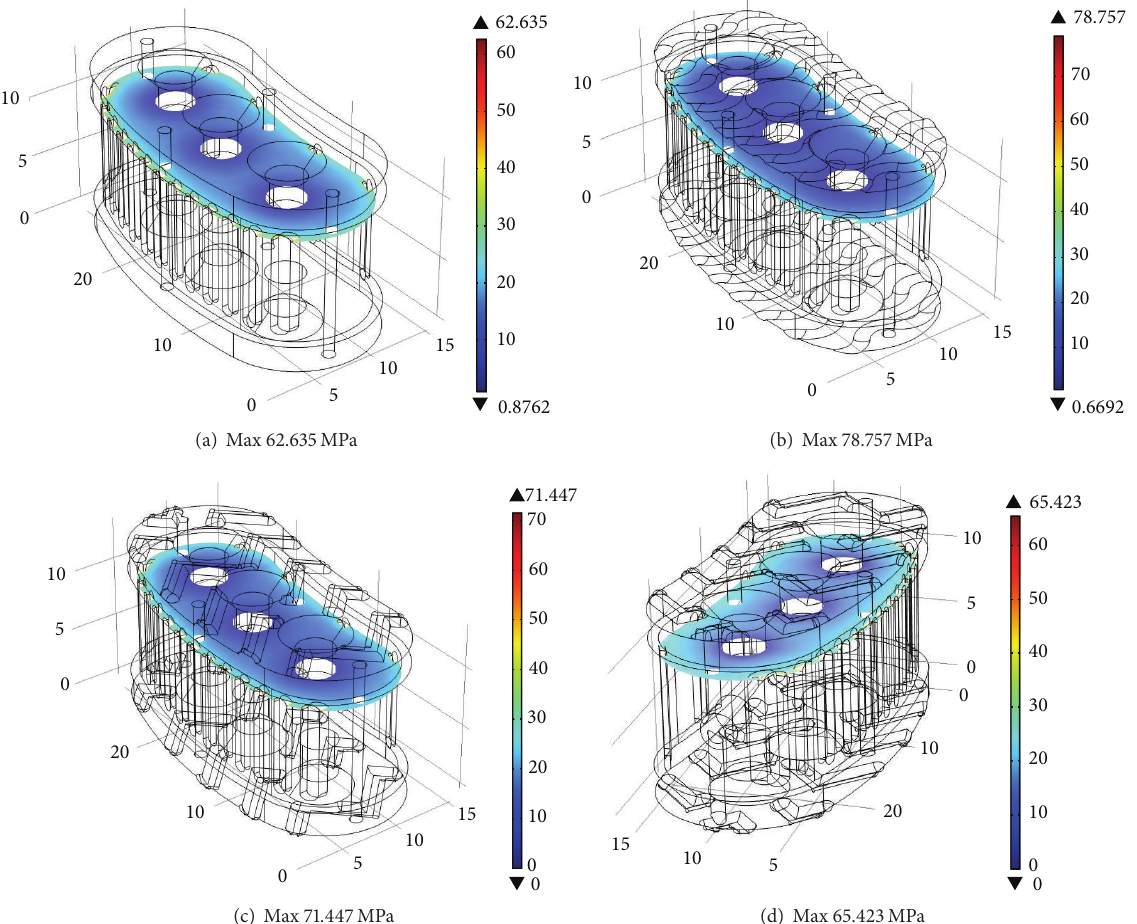
Figure 9: Cross section analysis for top plane: von Mises stress distribution with 4,000 N as reference load.